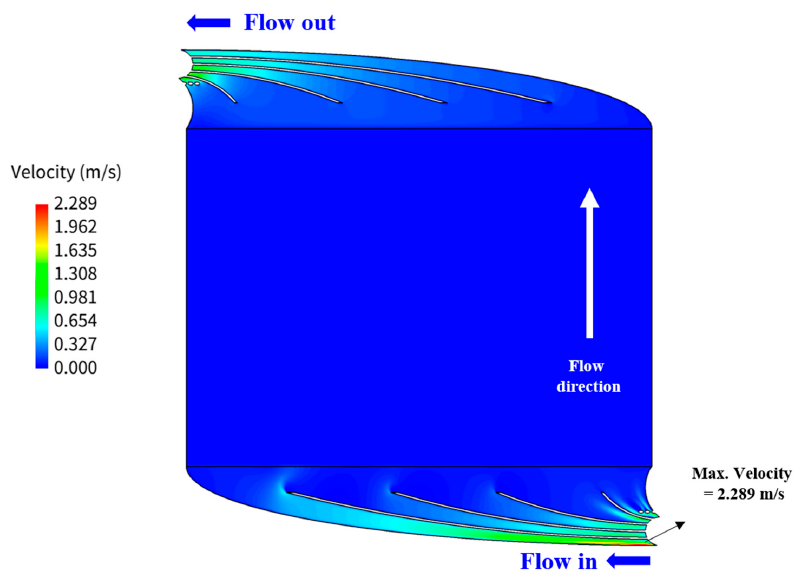
Figure 16. Flow distribution for CASE 2.